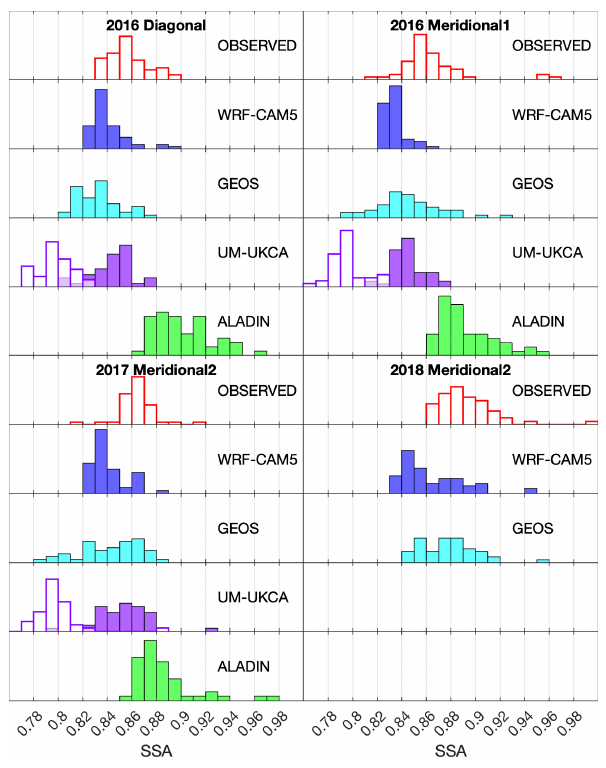
Figure 18. Histograms of SSA from the 2–5km altitude range only, as measured in situ from the P-3 and as modeled using WRF- CAM5, GEOS-5, UM-UKCA, and ALADIN for all samples along the comparison transects. For the UM-UKCA model, values are shown for both ambient RH aerosol (filled bars) and dry aerosol (unfilled bars); the observed values are available only for the dry aerosol (unfilled